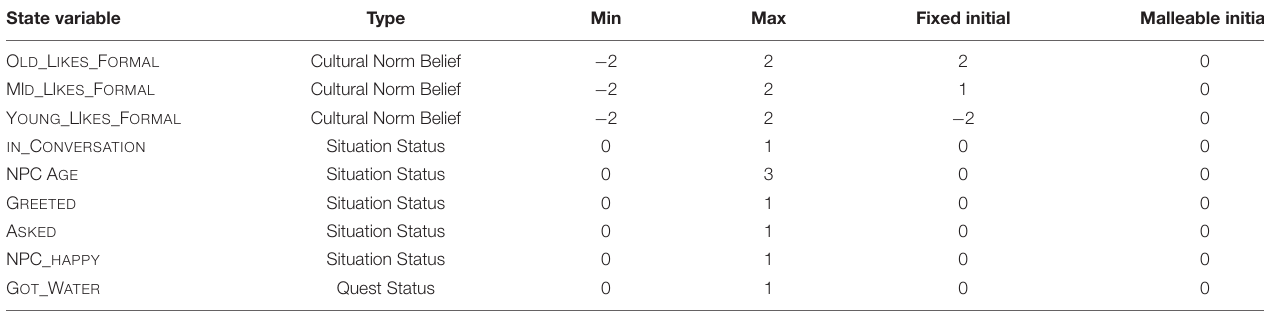
TABLE 2 | State space variables, their type and range, and the initial values for fixed and malleable mindset models. State variable Type Max Fixed initial